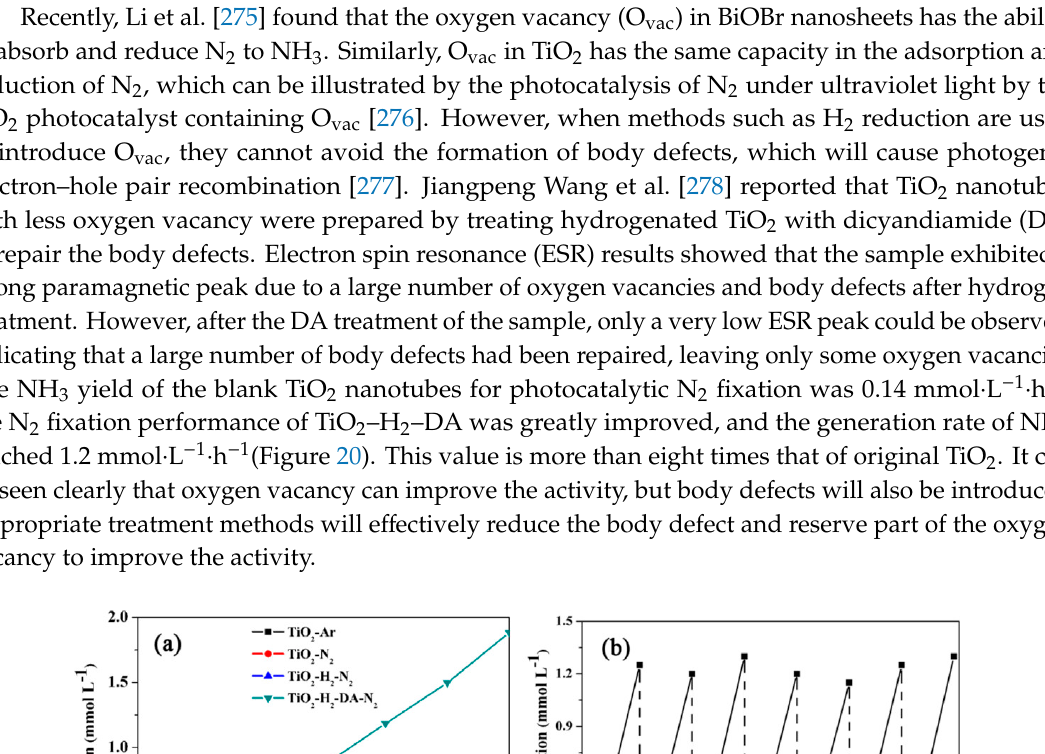
Figure 19. Photocatalytic nitrogen fixation mechanism by TiO 2 (B) nanotubes. Reprinted with